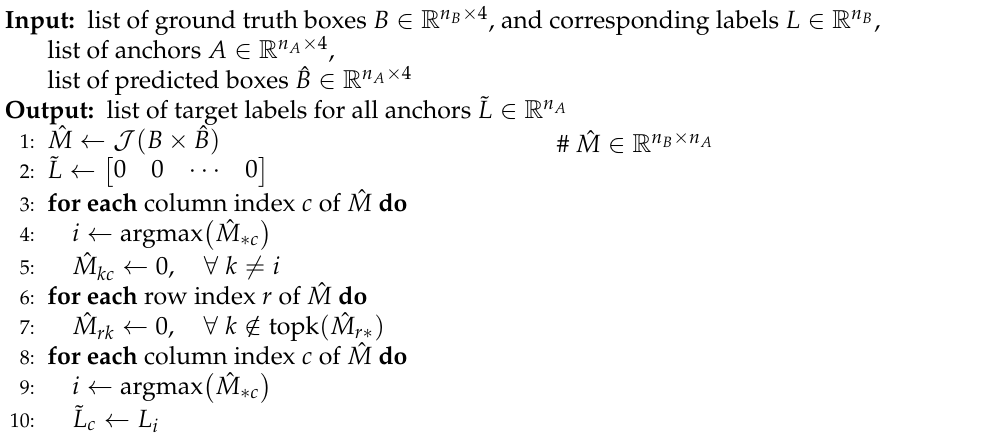
Algorithm 2 Generating classification targets from predicted